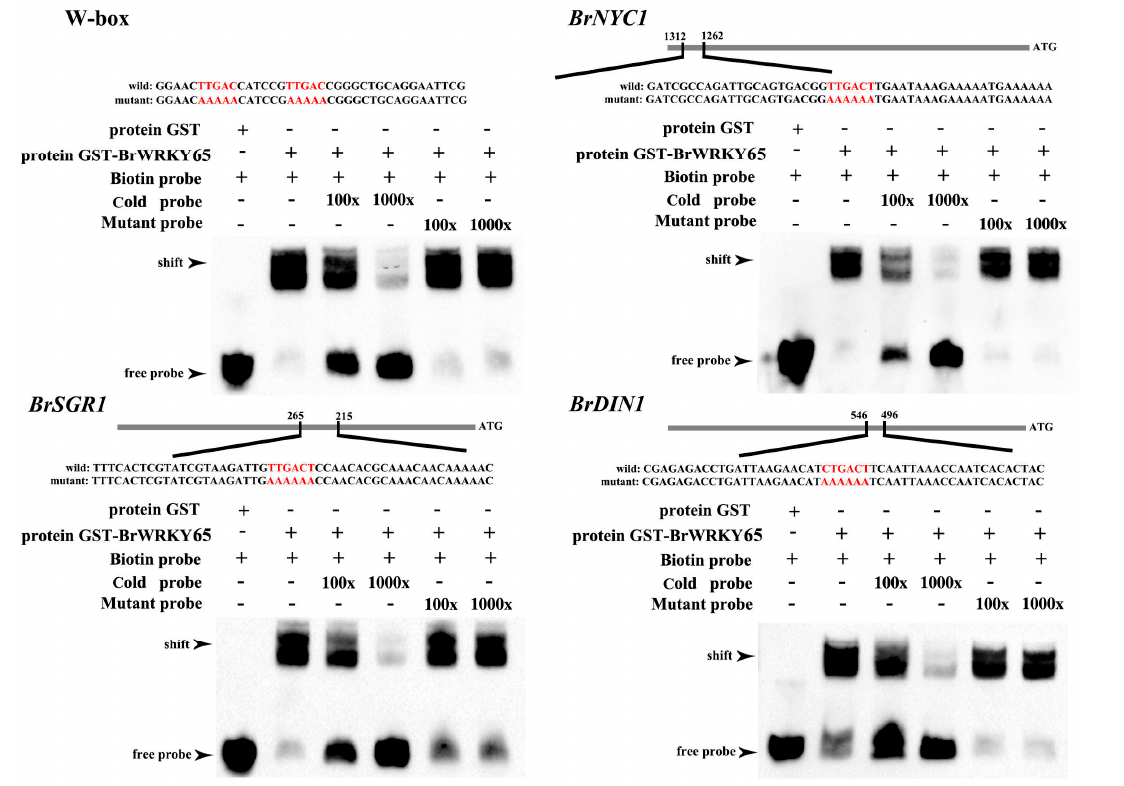
Figure 5. Electrophoretic mobility shift assay (EMSA) of BrWRKY65 binding to the W-box element and promoters of BrNYC1 , BrSGR1 , and BrDIN1 containing W-box element. The probe sequences corresponding to each of the target gene promoters are shown, with red letters representing the W-box and the mutant W-box. The purified recombinant GST-BrWRKY65 protein was incubated with probes, and the protein–DNA complexes were separated on native polyacrylamide gels. GST protein alone was used as the negative control. − represents absence, while + represents presence. Unlabeled or mutant probes at different concentrations (from 100 to 1000 times) were added to the reaction mixture for competition and testing binding specificity. Arrows indicate the position of shifted bands.